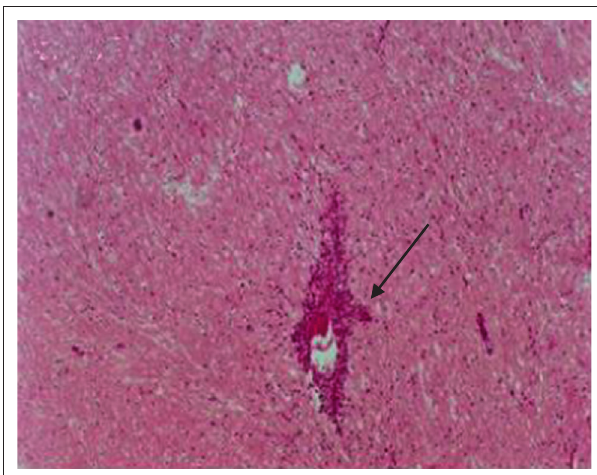
FIGURE 7: Perivascular cuffing (indicated by the shaded arrow) in a parasite- relapse mouse brain